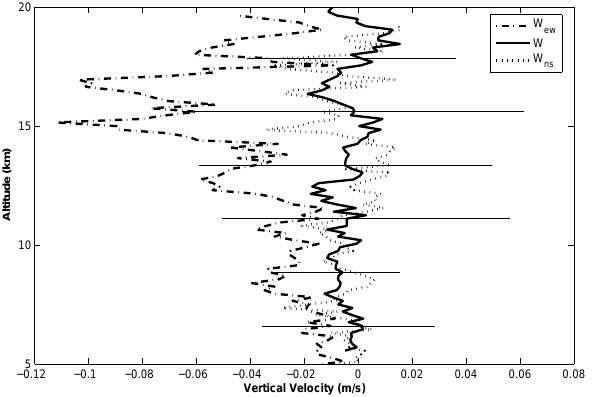
Fig. 6. Comparison of derived vertical velocities ( W ew and W ns ) with direct